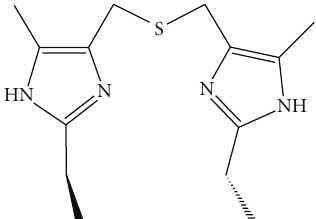
Figure 1: Schematic drawing of the ligand bemims